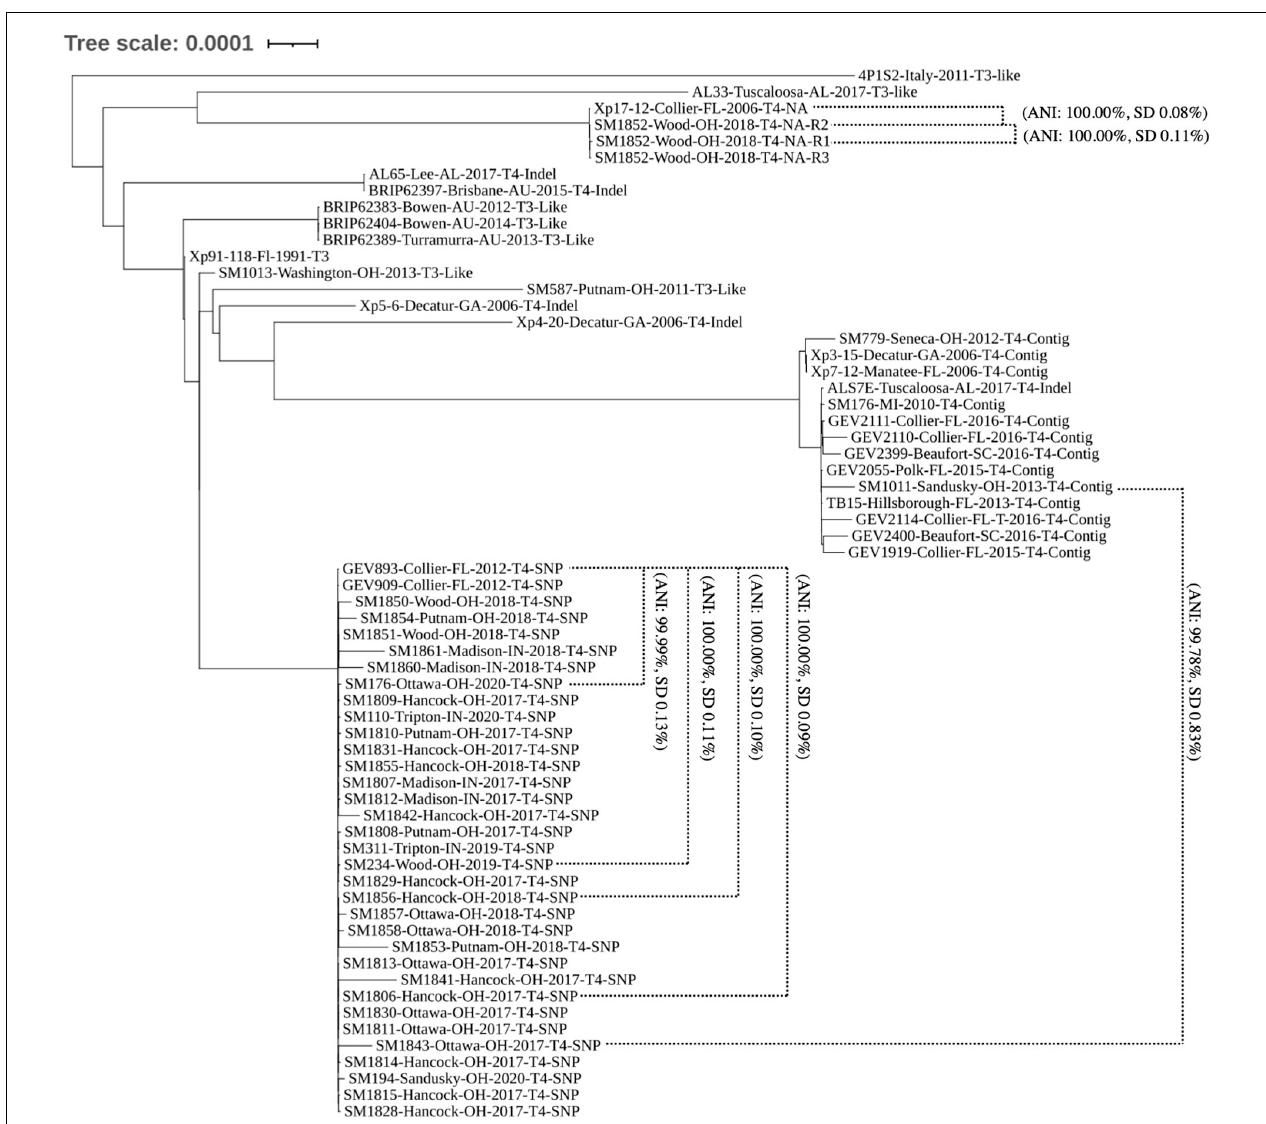
FIGURE 3 | Phylogenomic tree of X. perforans isolates geographically distributed worldwide. Phylogenomic tree of 64 Xanthomonas perforans strains based on whole genome sequencing. Strains are denoted by the name, location of isolation, year, race-type, and known mutation in avrXv3 . NA refers to the absence of avrXv3. Two-way-Average Nucleotide Identity values and standard deviations are denoted for specific comparisons between and within clades. The majority of strains isolated and sequenced in 2017–2020 are genetically identical. These strains group under the same clade as strains GEV909, GEV893 isolated from Florida in 2012. These strains all have the same SNP mutation in avrXv3 .